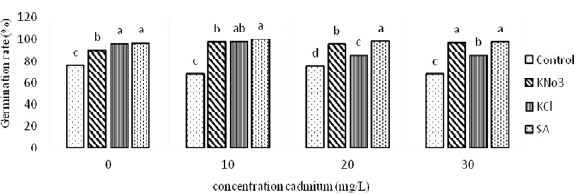
Fig. 2. Germination rate of unprimed (UPS) and primed (PS) fenugreek seedlings ( Trigonella foenum-graecum L.) under different Cd concentrations Germination rate was measured in unprimed seeds and when seeds were primed by 100 mg/L SA and -1 MPa KNO 3 and KCl solution for 24 hours. The unprimed seeds were used as the control. Means with similar letters resulted in no significant different (p ≤ 0.05) based on LSD test .